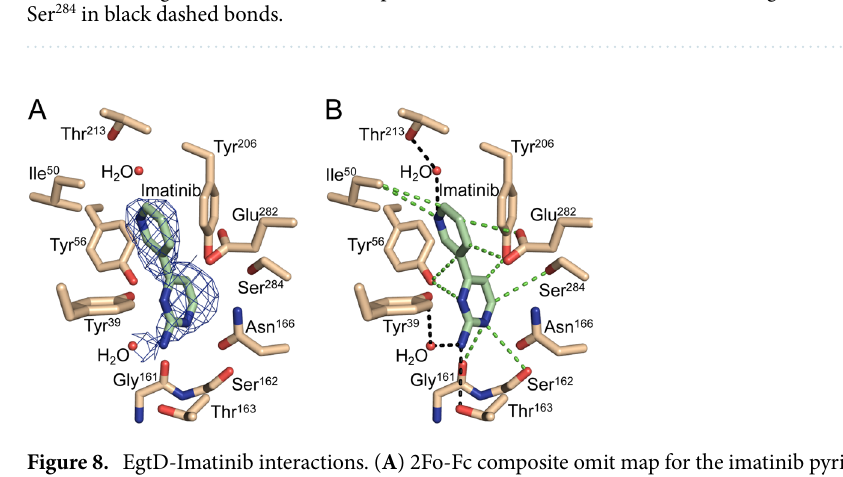
Figure 8. EgtD-Imatinib interactions. ( A ) 2Fo-Fc composite omit map for the imatinib pyridine-pyrimidine moiety at 1.3 σ and the interactions with the residues of the L-Histidine binding site that support complex formation. ( B ) Polar interactions are indicated with black dashed bonds and van der Waals interactions with green dashed